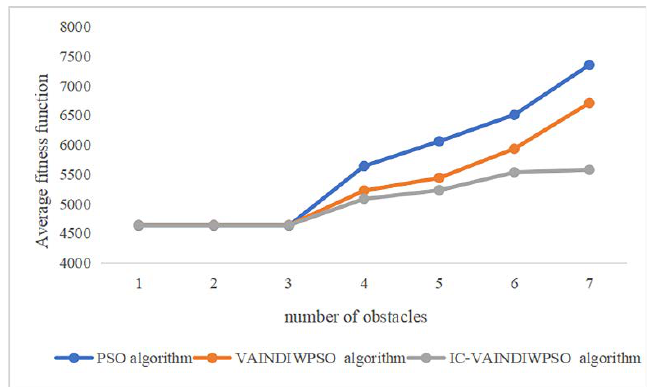
Figure 13. Average of fitness functions for different numbers of threats. Table 6. Data comparison of three algorithms with three threats.